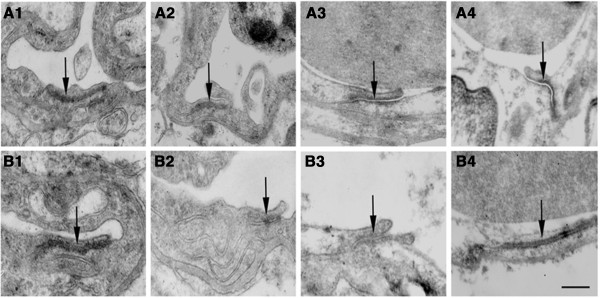
The postischemic ultra structure of TJ after GTPs administration was examined by TEM. Representative graphs of the following groups: A1–A4, the vehicle group at 0, 30, 60, and 120 min after ischemia; B1–B4, the GTPs group at 0, 30, 60, and 120 min after ischemia, respectively. Graphs (A1, A2, B1, B2, B3, B4) show that TJ barrier was intact. Graphs (A3, A4) display an increase in the gap at TJ. Arrows show TJ. Scale bars = 400 nm.